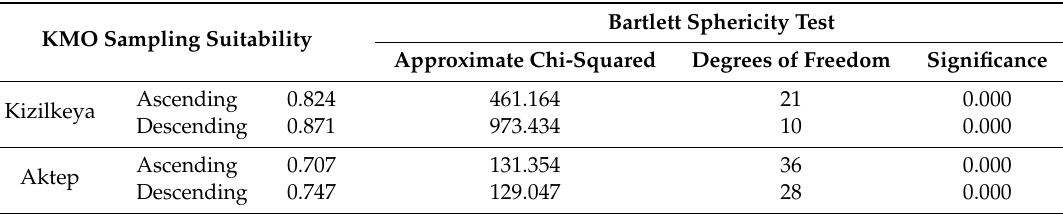
Table 4. Statistics of Kaiser–Meyer–Olkin (KMO) and Bartlett test